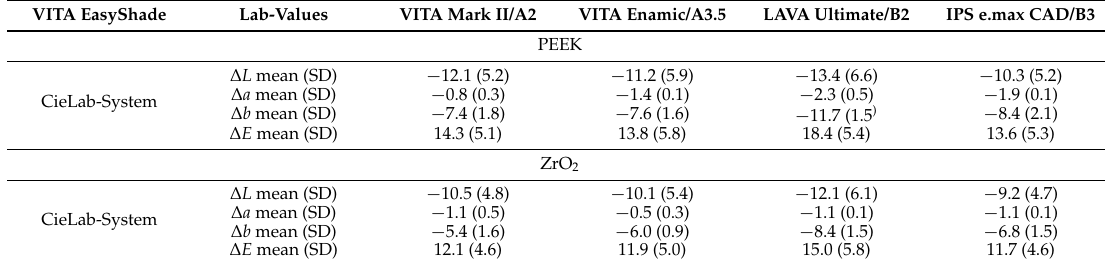
Table 4. Descriptive statistics of modifications of the CieLab-System parameters (baseline: veneering material) of all tested material assemblies, regardless of the veneering